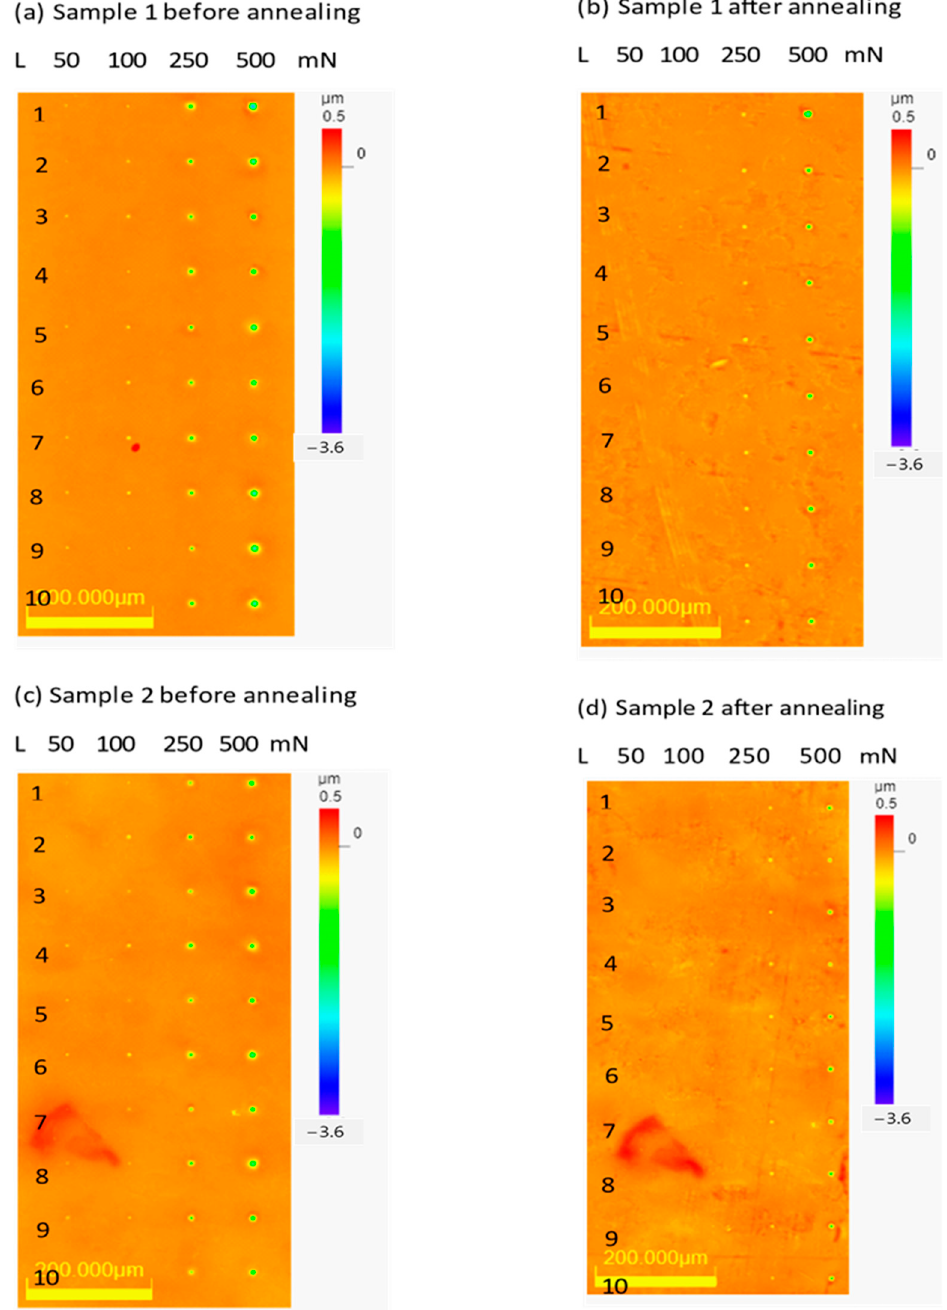
Figure 9. ( a – d ) Microscopic images of samples 1 and 2 before and after annealing in height mode (10 indent points for each load of 50, 100, 250 and 500 mN) with a spherical indenter of radius 5 µm.